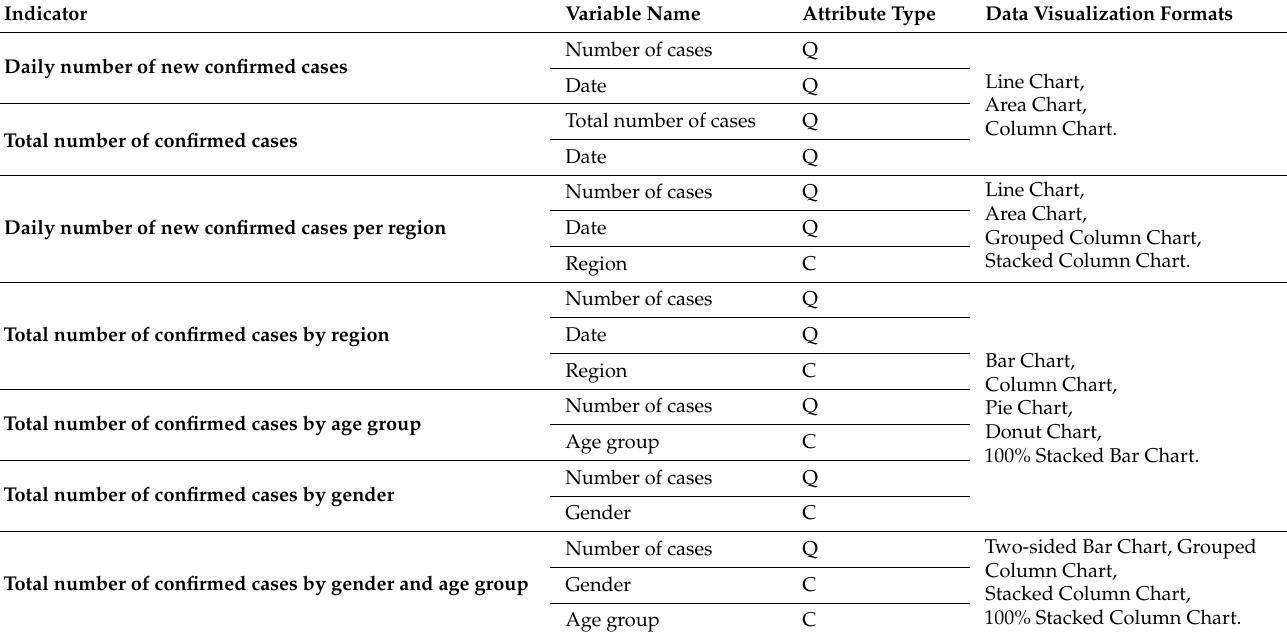
Table 2. Indicators and corresponding data visualization formats.